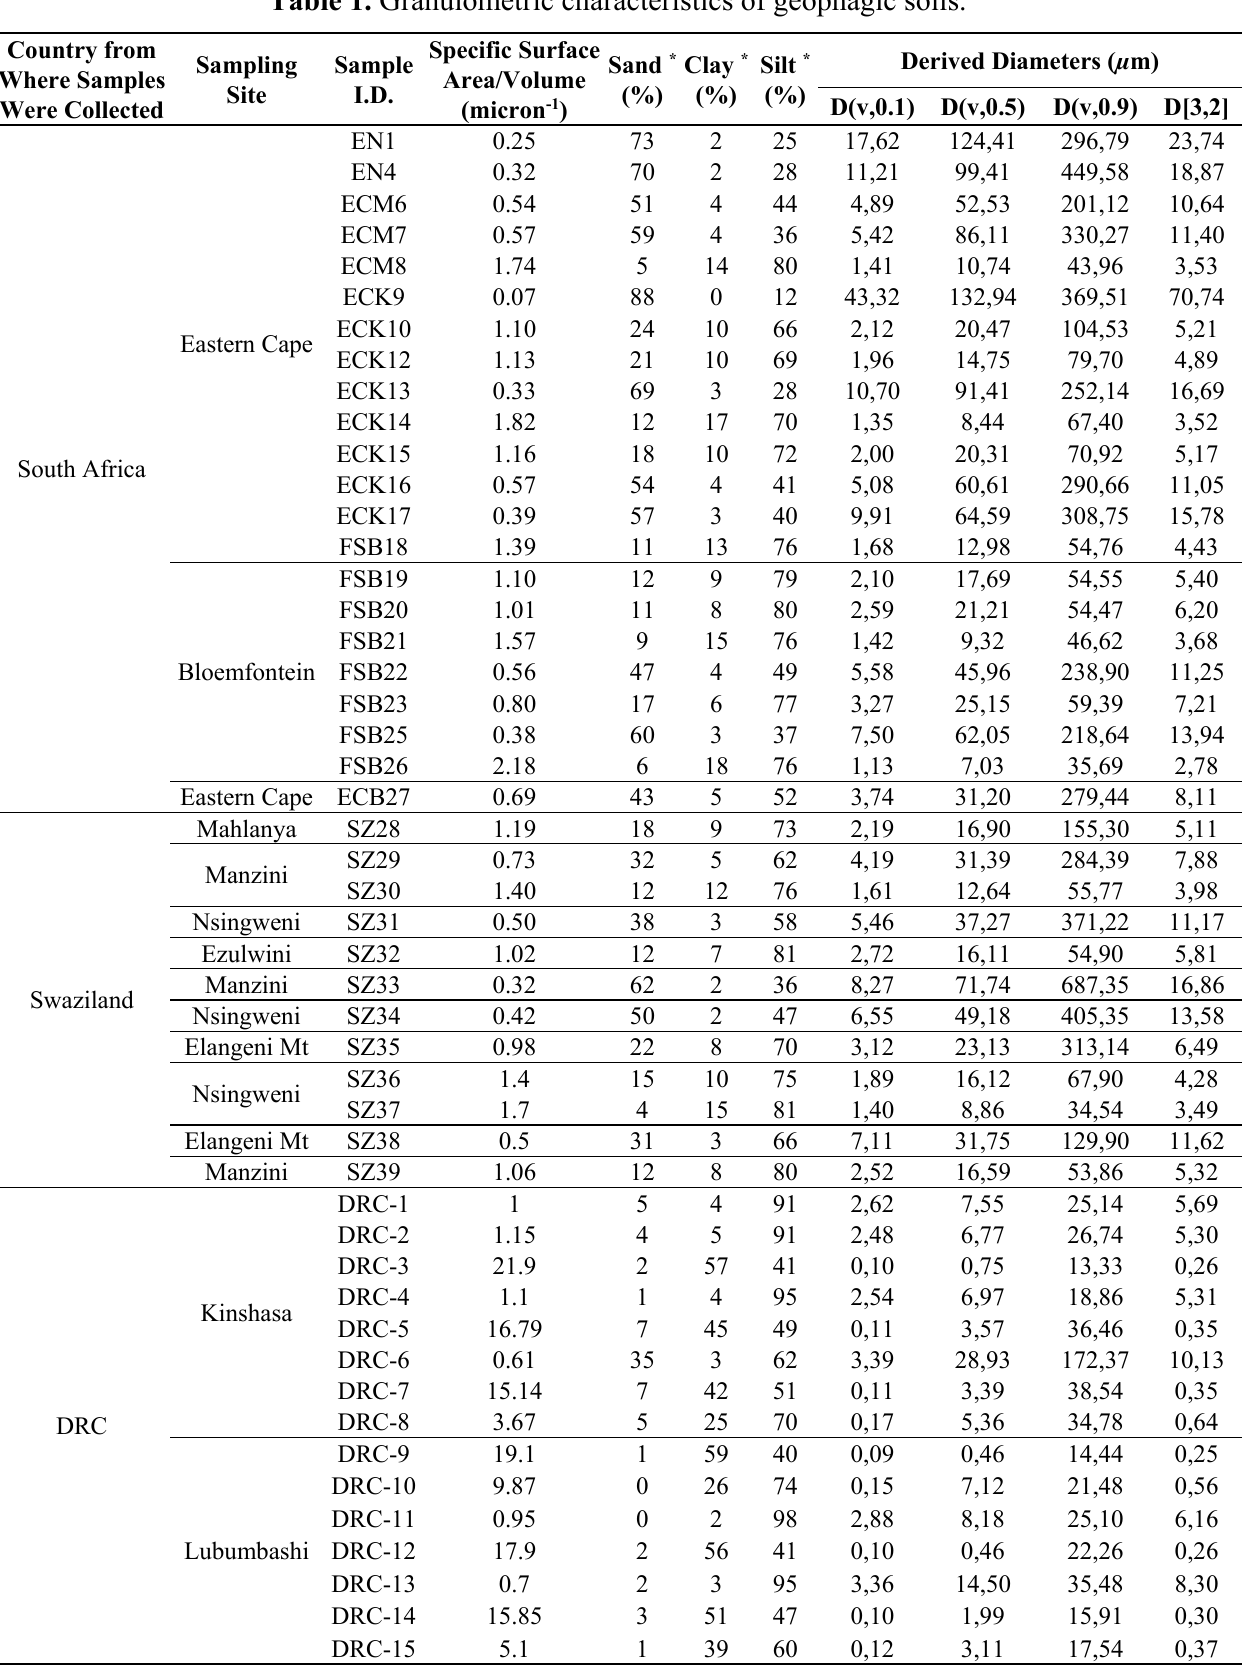
Table 1. Granulometric characteristics of geophagic